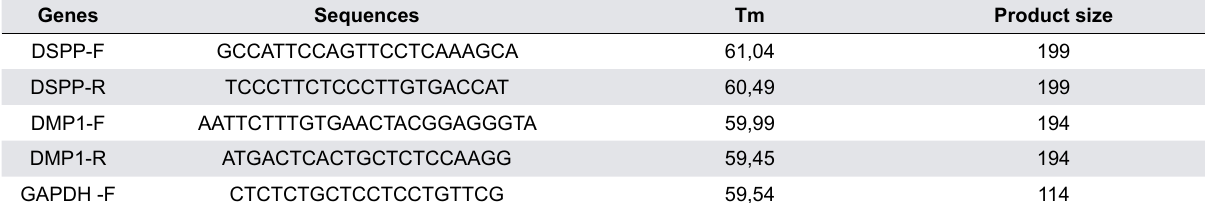
Table 1- Odontogenic markers' primer